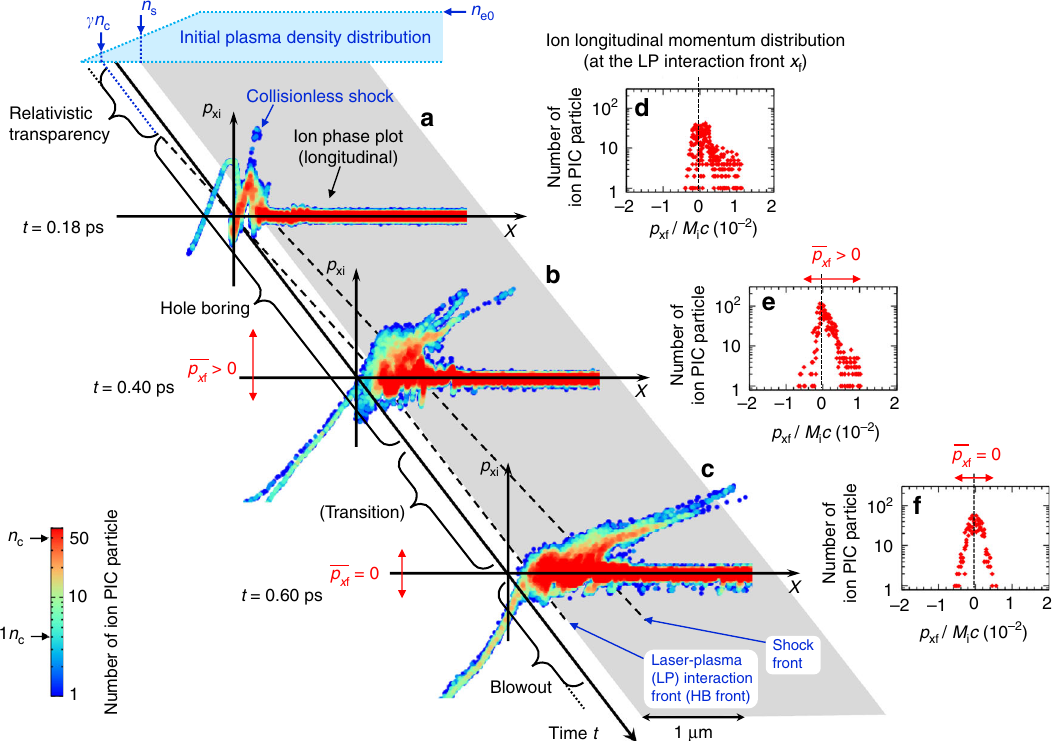
Fig. 1 Time evolution of the interaction of solid plasma surface with a relativistic laser light. a – f are the results of a particle-in-cell simulation in one- dimensinal geometry. A linearly polarized laser light with the peak intensity of 5 × 10 18 W cm − 2 ^ a 0 ¼ 2 ð Þ is irradiated from the left boundary with a 0.15 ps Gaussian pulse leading edge. A fully ionized deuteron plasma of an overdense density n e0 ¼ 40 n c and a 1 μ m pre-plasma with linear density gradient is initially distributed. a – c are the phase plots of ions in the longitudinal direction at times t = 0.18, 0.40, and 0.60 ps, respectively, where the color represents the number of PIC particle. In d – f , the longitudinal momentum distributions at the laser-plasma (LP) interaction front at the corresponding times are presented. Here, the momentum p x f is normalized by M i c where M i is the ion rest (cid:4) (cid:5) 1 = 2 is = 2 simulation of Fig. 1. The relation γ (cid:4) 1 þ ð 1 þ R Þ ϵ 2 ^ a 2 0